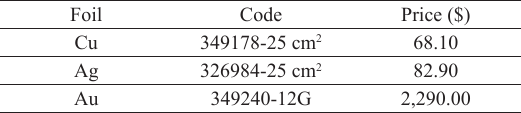
Table 3. Comparison of the costs of 0.25-mm-thick Cu, Ag, and Au foils with an area of 25 cm 2 (Sigma Aldrich). Foil